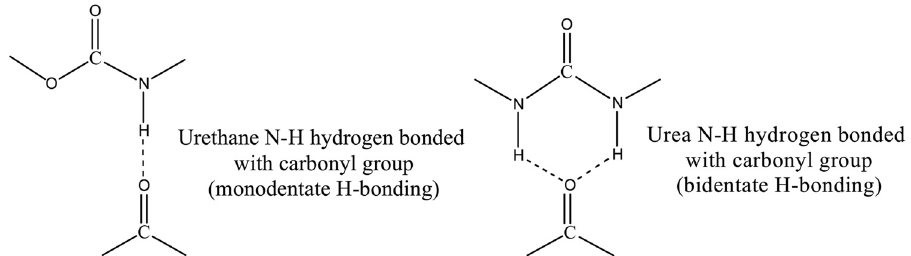
Figure 2: Polyurethane and polyurea functional group and mono - and bidentate hydrogen bonding between hard segments [ 46 ]